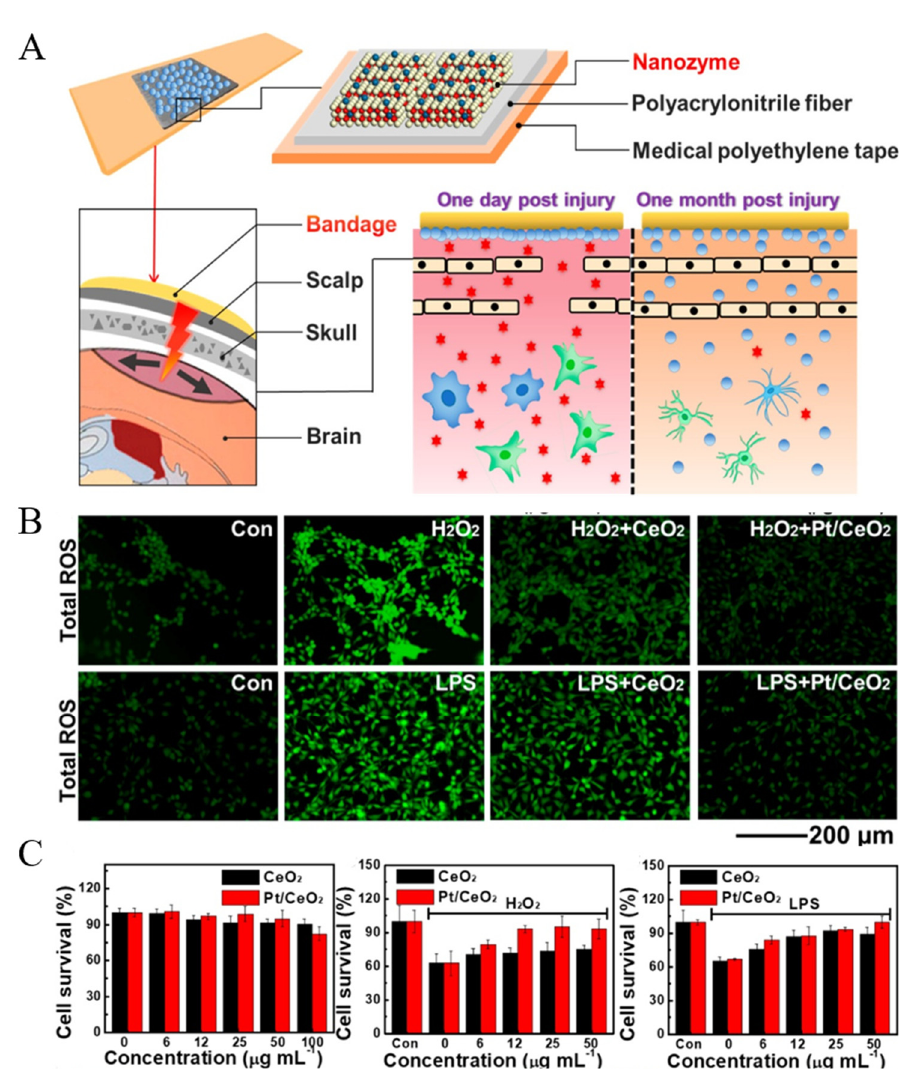
Figure 8. ( A ) Design principle of Pt@CeO 2 bandage. ( B ) ROS scavenging abilities of Pt/CeO 2 inside cells. ( C ) Alleviating cellular oxidative damage abilities of Pt/CeO 2 [105]. Copyright 2019, American Chemical Society.